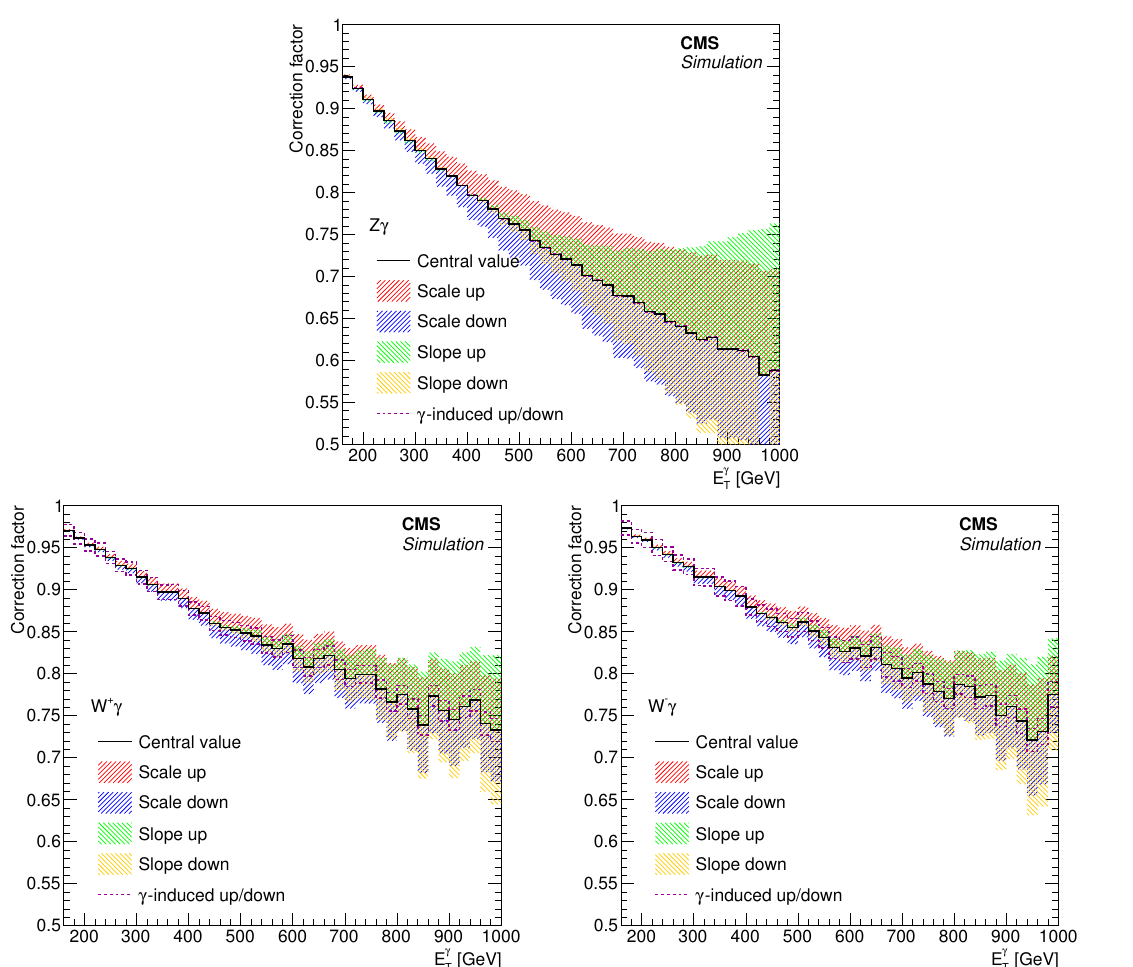
Figure 12 . Electroweak NLO cross section corrections as a function of photon p T for Z( ! (cid:23)(cid:23) )+ (cid:13) (top), W + + (cid:13) (bottom left), and W (cid:0) + (cid:13) (bottom right) processes, overlaid with uncertainty bands. See text for descriptions of the individual components of the uncertainty. Uncertainty due to (cid:13) -induced production is negligible in Z( ! (cid:23)(cid:23) )+ (cid:13) production.